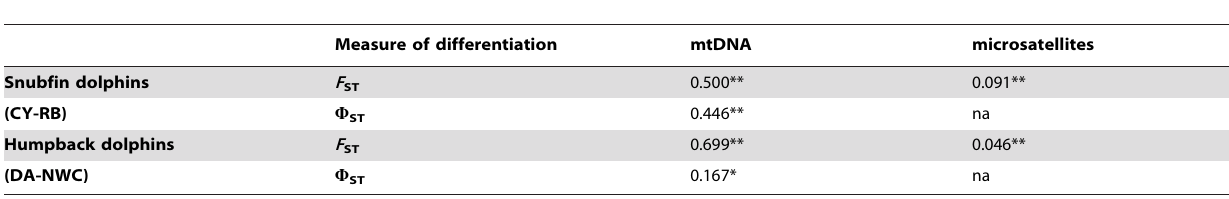
Table 2. Genetic differentiation of mtDNA and microsatellite loci.